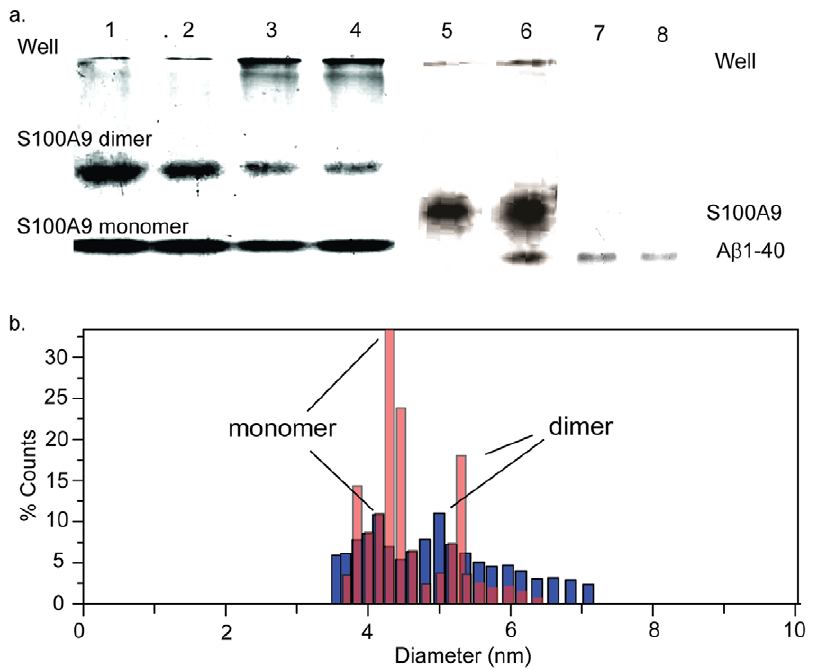
Figure 6. Electrophoresis and gas-phase electrophoretic mobility molecular analysis (GEMMA) of S100A9 and S100A9/A b 1–40 mixture. (a) SDS PAGE of S100A9 with (1) 0.002 mM; (2) 0.01 mM; (3) 0.02 mM; (4) 0.1 mM A b 1–40 and native PAGE of (5) 0.2 mM S100A9 with 0.01 mM A b 1–40; (6) 0.2 mM S100A9 with 0.1 mM A b 1–40; (7) 0.1 mM A b 1–40; (8) 0.01 mM A b 1–40. The final concentration of S100A9 is 0.2 mM. The data was obtained by several experiments, and integrated together according to the ladders. (b) Size distribution of S100A9 monomer and dimer at pH 7.4 and 3.0 examined by gas-phase electrophoretic mobility molecular analysis (GEMMA). The red columns represent S100A9 at pH 7.4. The blue ones represent S100A9 at pH3.0.